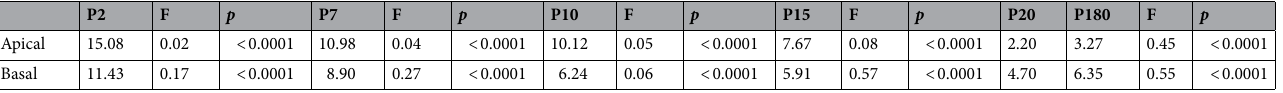
Table 1. Differences between slow axis of orientation in developing BM. Slow axis of orientation was measured in the apical and basal regions at different stages of development. SD were compared, as a measure of fiber disarrangement. The developmental disorganization of the collagenous elements as reflected in the SD. The comparison between different ages versus P20 was made, as reflected in reported F and p